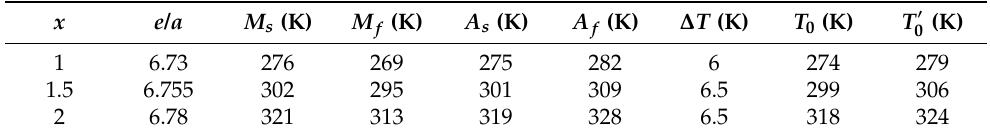
) of direct and reverse MTs 0